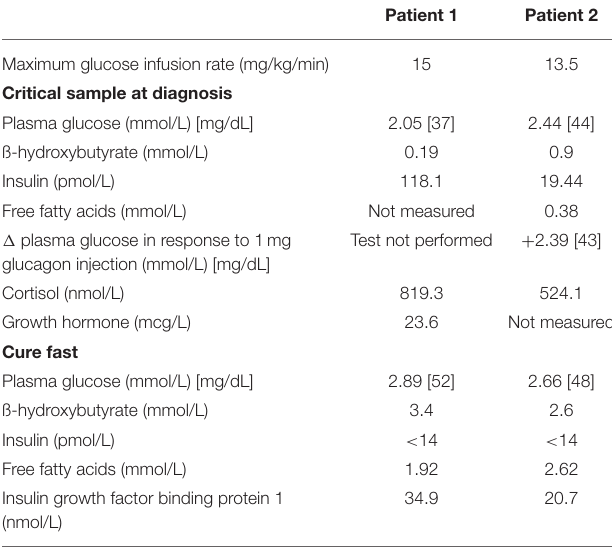
Patient 1 Patient